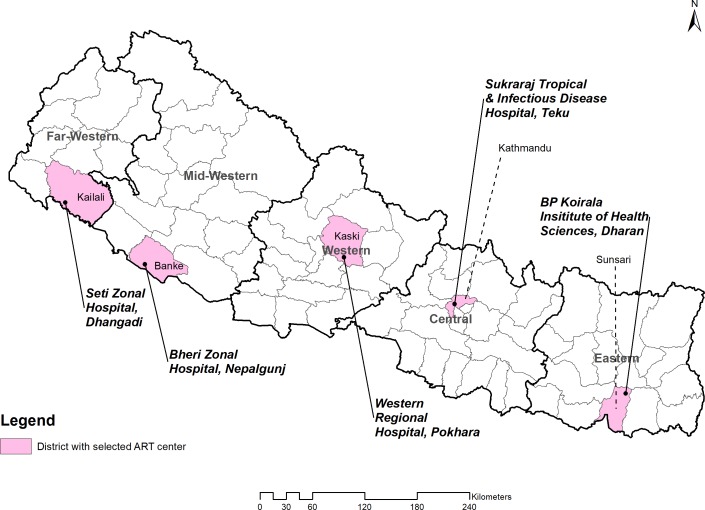
Sampled ART centers in each development region.